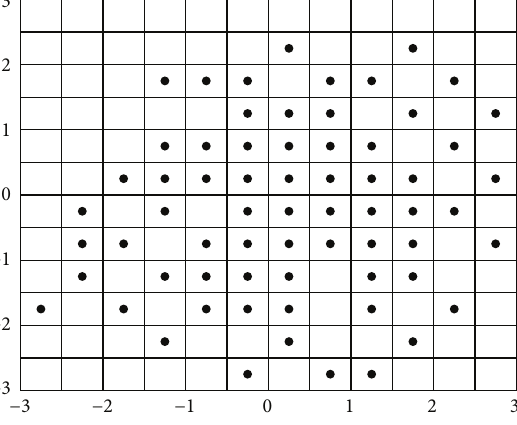
Figure 4: Array configuration for 28 elements.